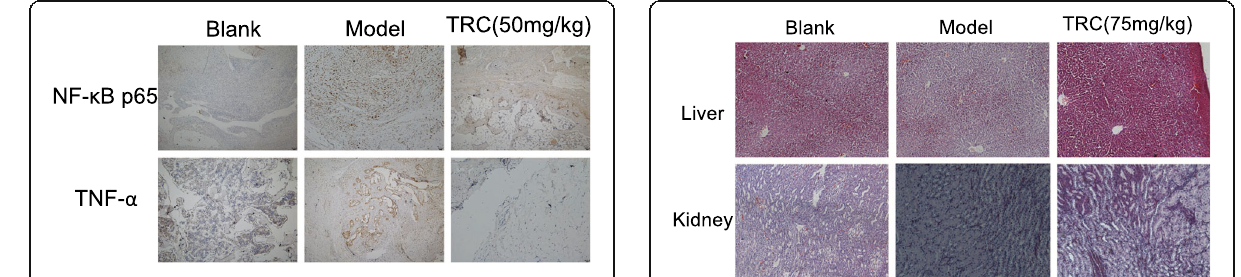
Fig. 6 Immunohistochemical analysis of NF- κ B p65 and TNF- α in the ankle joints of CIA rats (100×). At the end of the experiment, paraffin sections of ankle joints were used to immunohistochemical research to show the presence of NF- κ B p65 and TNF- α . Compared with the blank group, the model group displayed increase expression. On the other hand, the 50 mg/kg dose of the TRC combination showed weak cytoplasmic staining